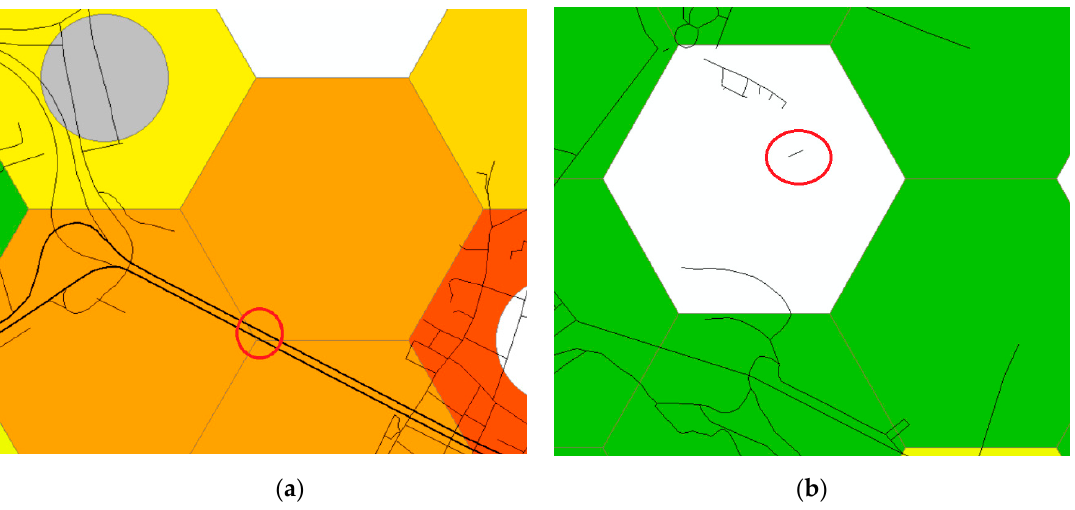
Figure 8. ( a ): A nearly empty tile gets a rather high criticality value, because it cuts an important segment. ( b ): A tile is considered unreachable, because the segment closest to the centre of the tile belongs to an isolated subnet.